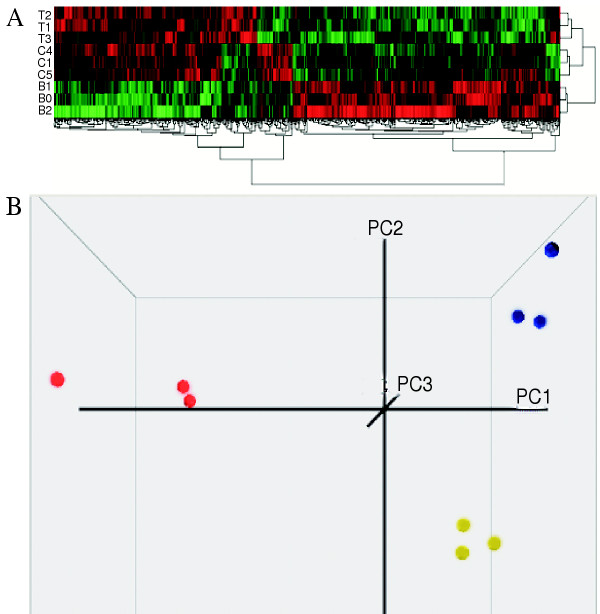
Clustering of microarray data. A. Agglomerative Hierarchical Clustering of microarray data (P < 0.05, Group T, C, B represent individual samples with ectopic expression of tkv, control, and babo respectively); B. Principal Component Analysis (PCA) of microarray data (P < 0.05, Spheres in red, blue and yellow represent individual samples with ecotopic expression of babo, tkv, and control respectively).